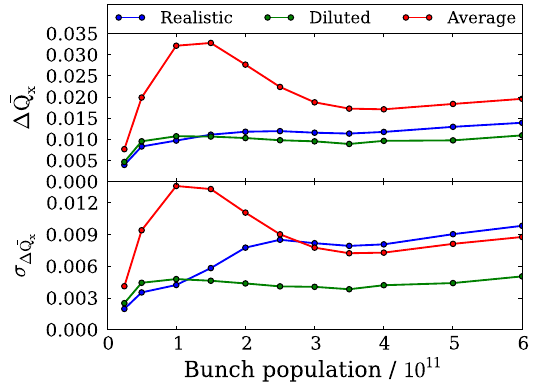
FIG. 12. The tune shift (upper graph) and its standard deviation (lower graph) as a function of bunch population in a field-free region. The blue curve shows the results for a nonuniform cloud. The green curve shows the results for the uniform, diluted cloud. The red curve corresponds to the uniform cloud. The SEY is δ ¼ 1 . 4 max